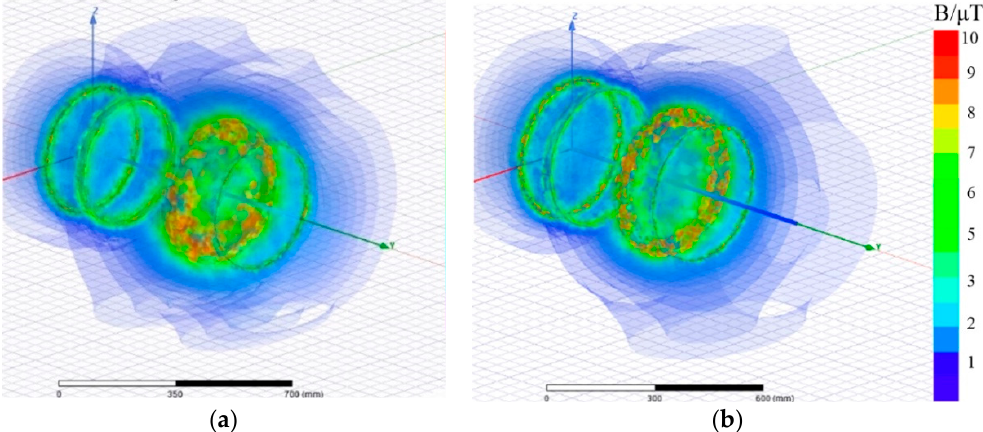
Figure 10. Electromagnetic simulations for magnetic flux B of (a) traditional four-coil WPT system and (b) proposed WPT system.